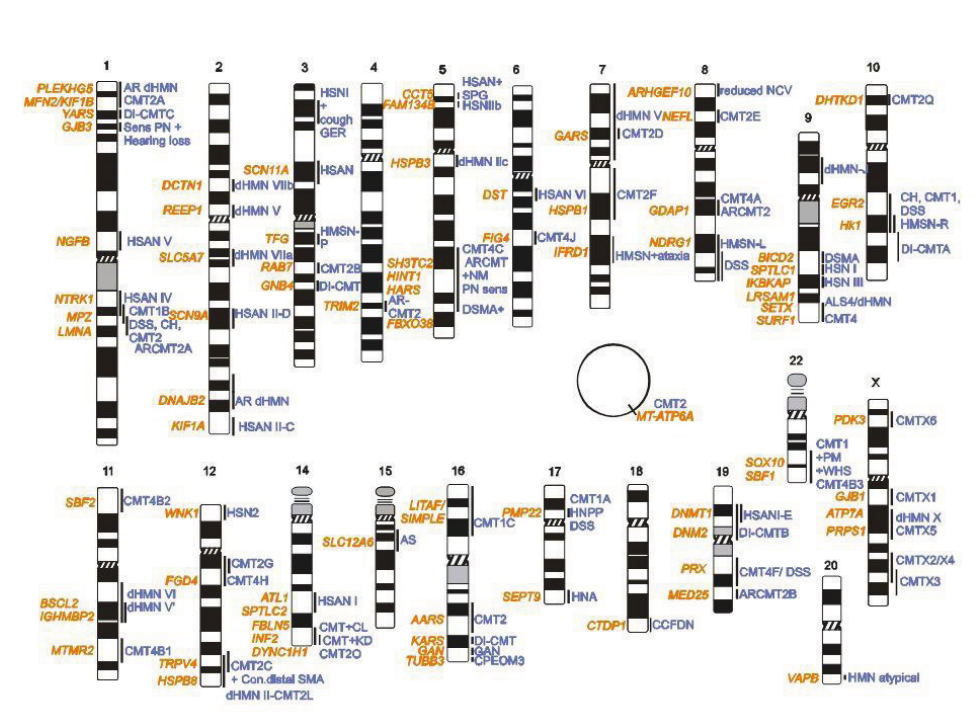
Figure 1. Genes and loci for Charcot-Marie-Tooth (CMT) and related inherited peripheral